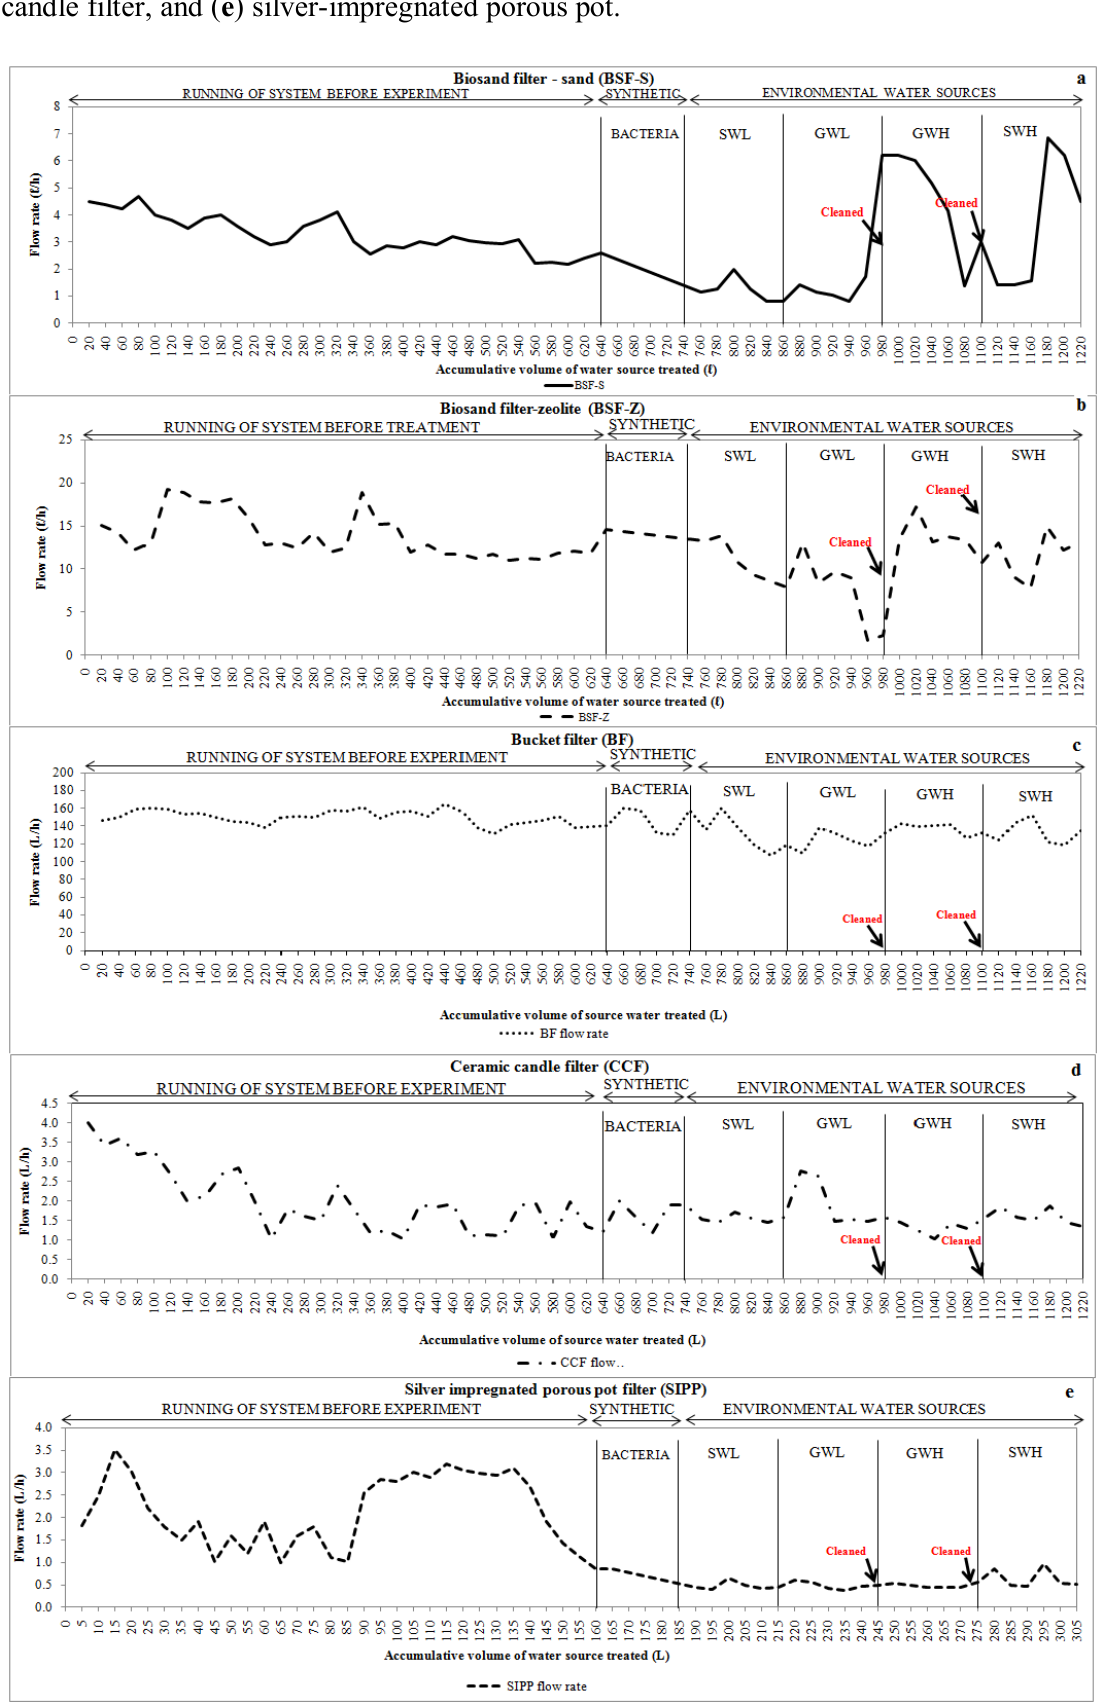
Figure 6. Flow rates of HWTS devices: ( a ) BSF-S, ( b ) BSF-Z, ( c ) bucket filter, ( d ) ceramic candle filter, and ( e ) silver-impregnated porous